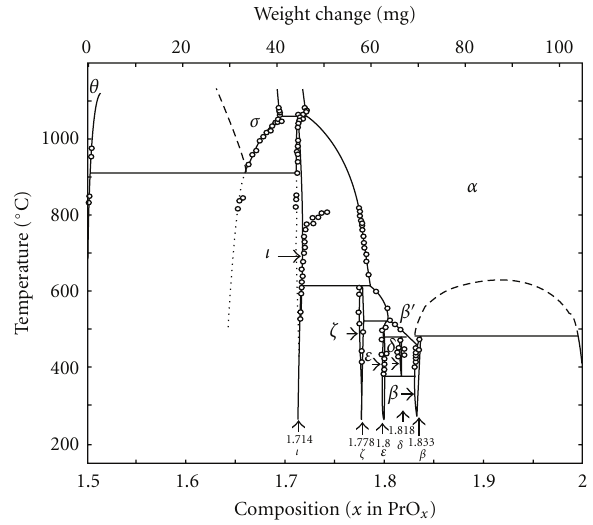
Figure 1: Projection of the phase diagram of the praseodymium- oxygen system on the temperature-composition plane. Reproduced from Ionics , 1999, 5 , 426. Copyright 1999, Springer-Verlag [6].